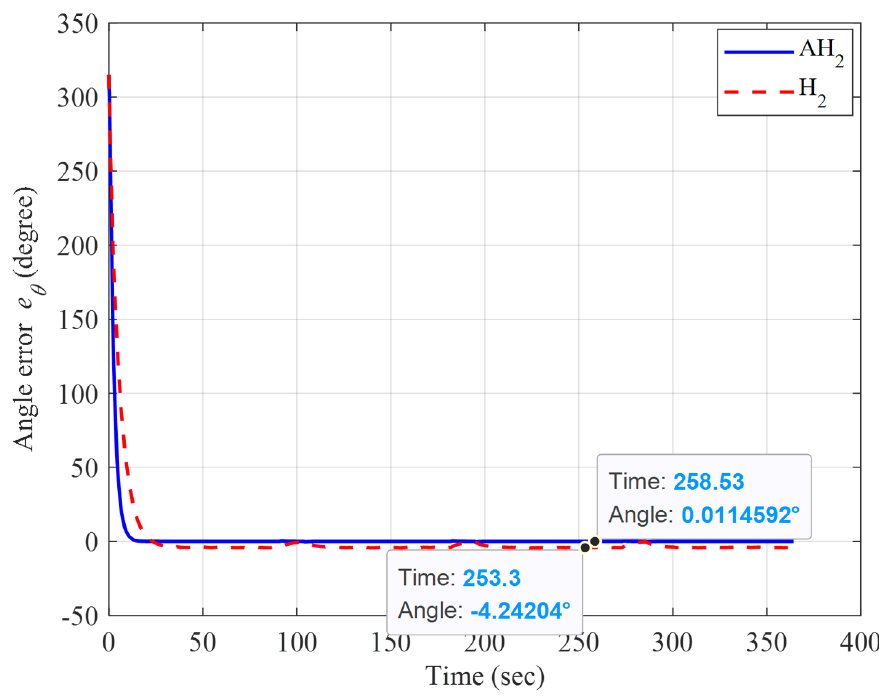
Figure 10. The square trajectory tracking error result of the adaptive H 2 closed-form and H 2 closed- form control approaches for an angle from x p = − 7 m, y p = 7 m.